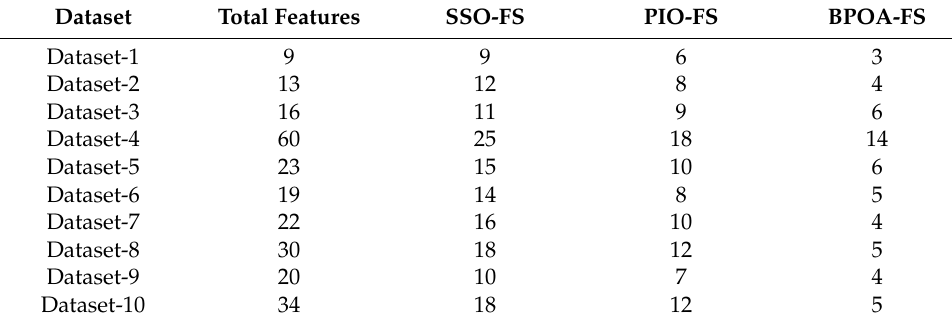
Figure 4. Selected feature analysis of the MOBDC-MR model. Table 3. Comparison of the various feature selection